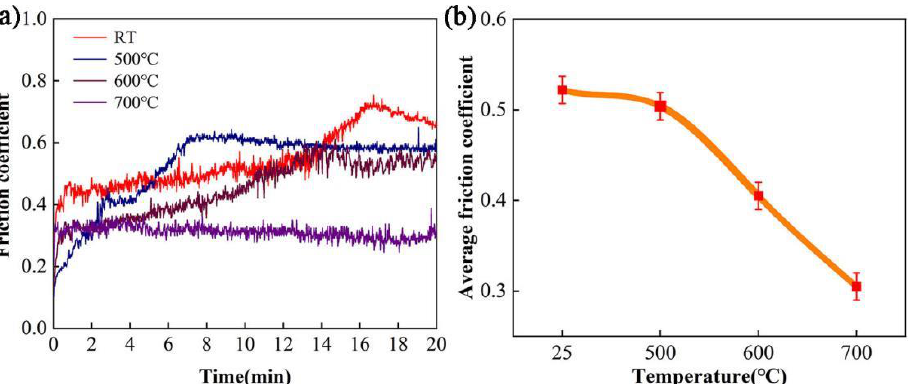
Figure 9. ( a ) Friction coefficient of the composite coatings after different thermal treatment temperature; ( b ) Average friction coefficient of the composite coatings after different thermal treatment temperature.